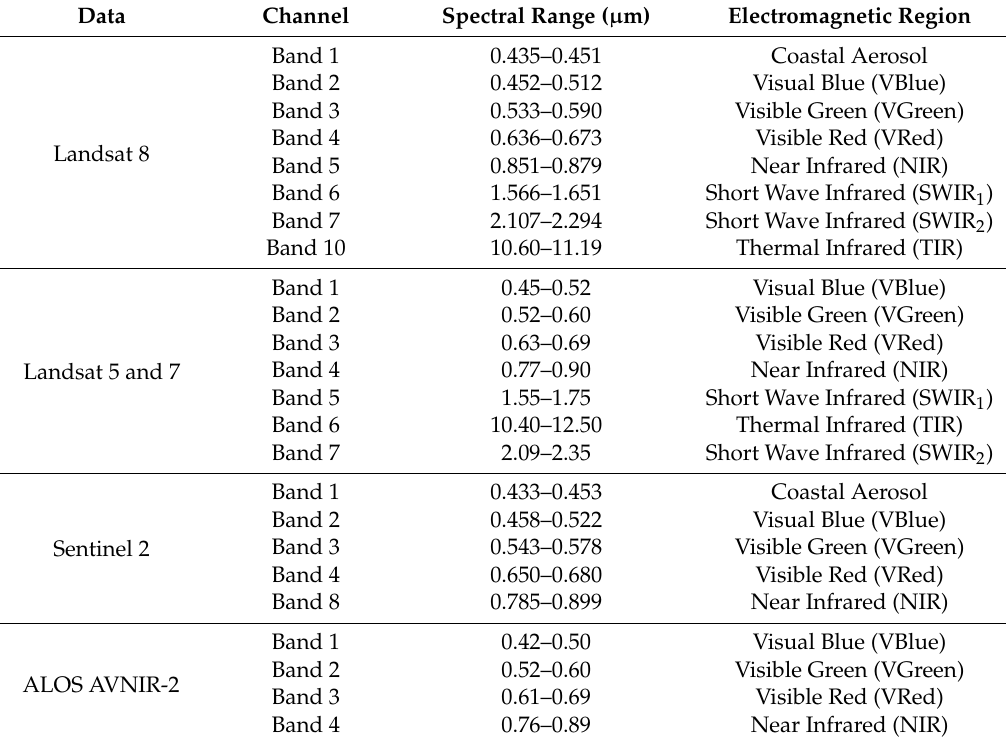
Table 3. The reference of spectral band information Landsat 5, 7, 8 [87], Sentinel-2 [88], and ALOS AVNIR-2 [89] used for the calculation of optical